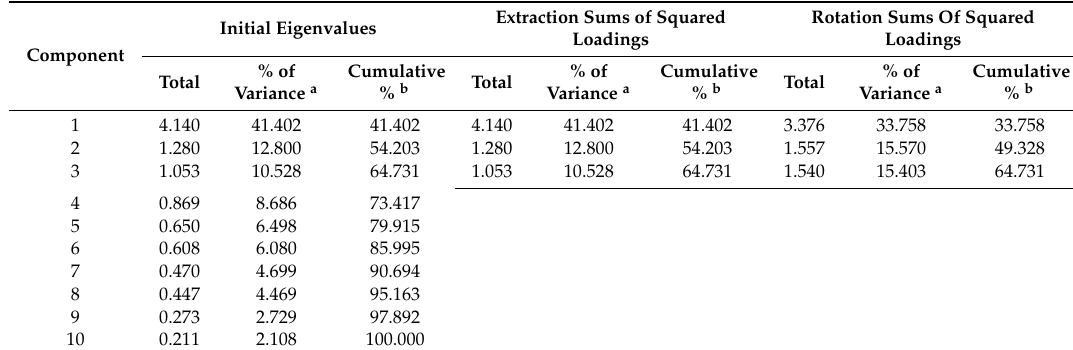
Table 3. Percentages of variance explained by the factor analysis performed using principal component